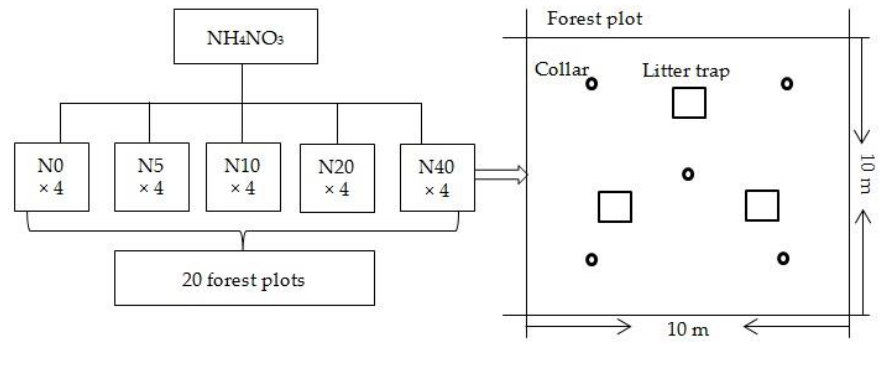
Figure 1. The experimental design at the study site. Table 1. Basic characteristics of forest soil and plants in different treatment plots before nitrogen addition.